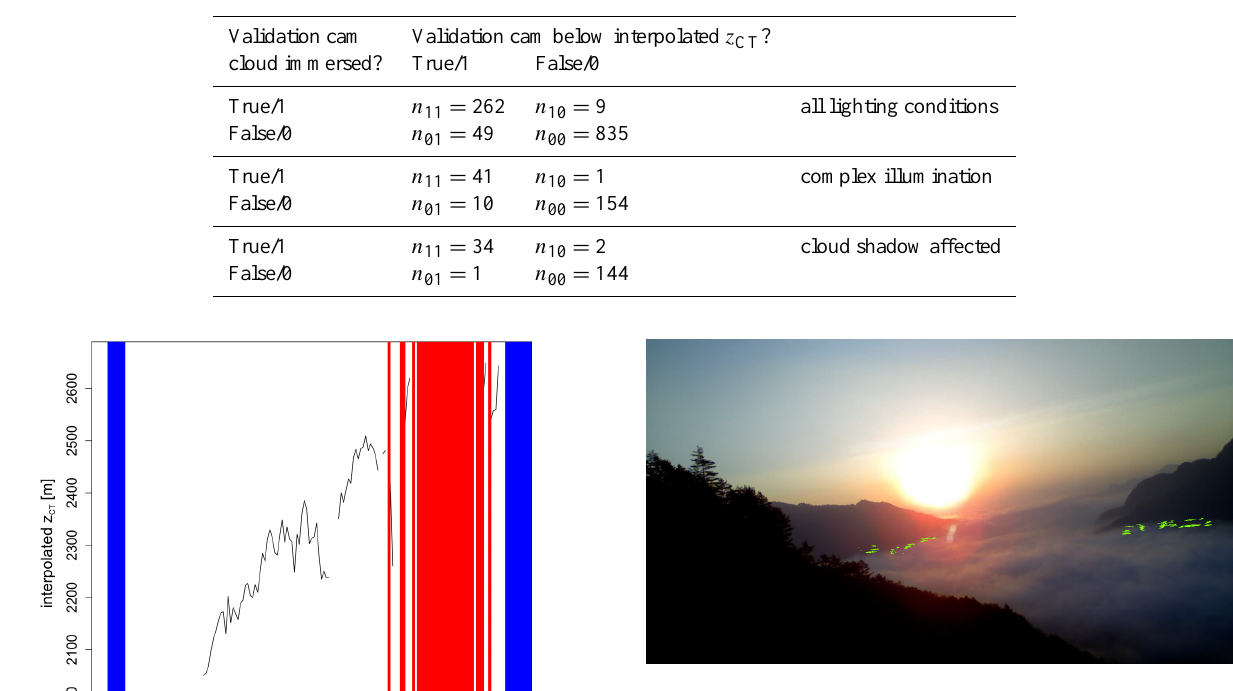
Figure 15. Cloud tops (green) detected in the scene taken on 19 March 2013 from 06:12 to 06:16UTC +